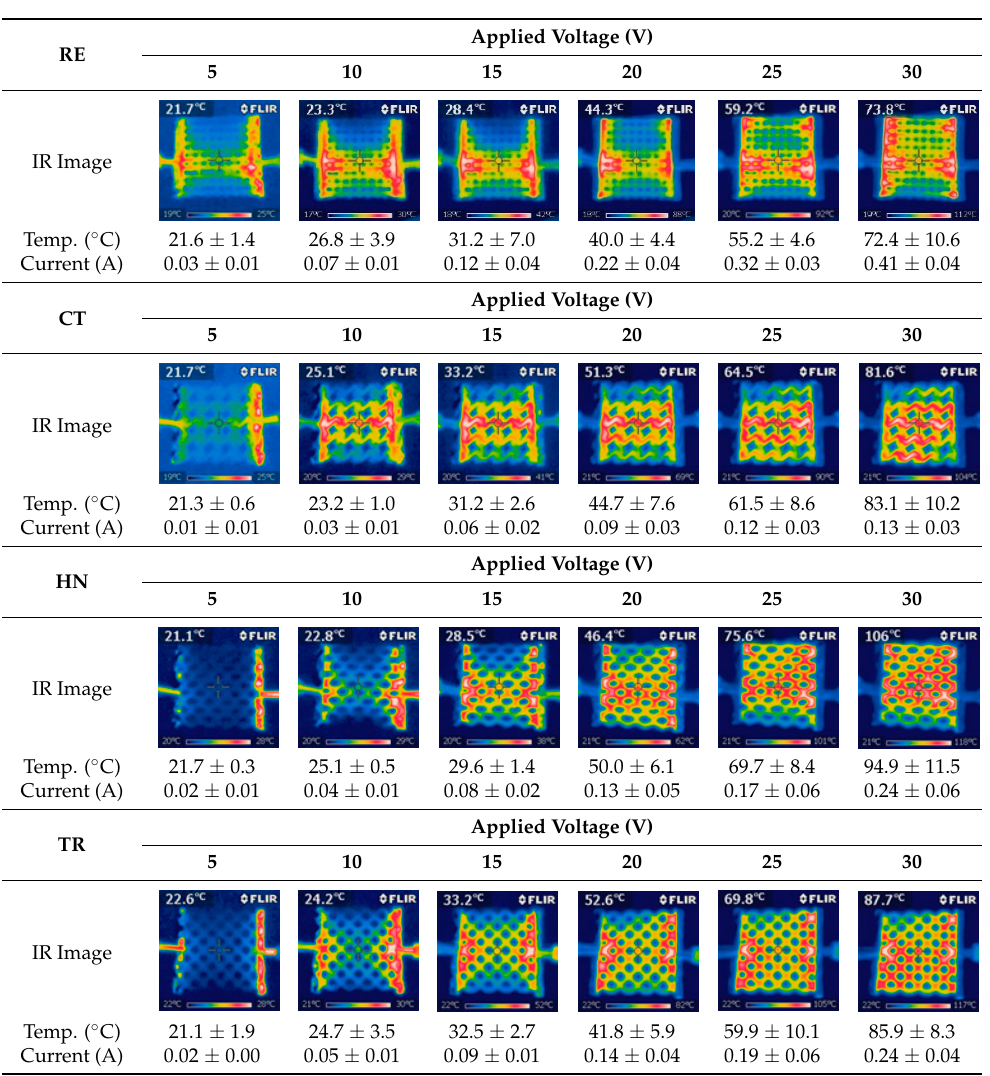
Table 3. IR images of 4 types of CFDM 3D printed graphene/PLA auxetic patterns with various applied voltages.